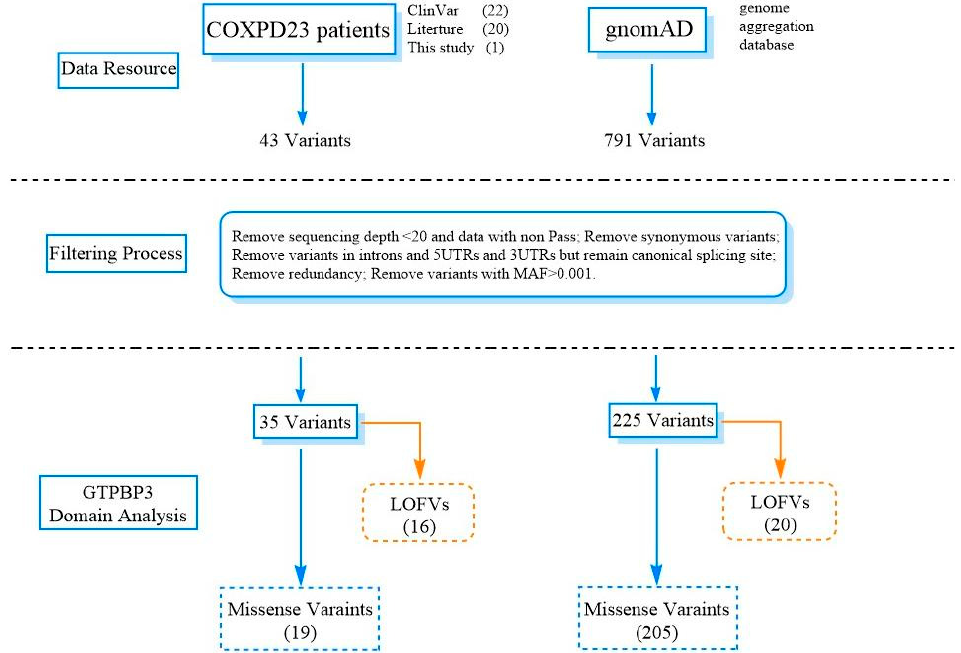
Figure 6. Workflow of the analysis of GTPBP3 variants. Comprehensive list comprising 791 variants from gnomAD and 43 pathogenic variants from ClinVar and clinical cases in the literature. Finally, it includes 225 rare variants from gnomAD and 35 pathogenic variants from clinical cases. LOFVs, loss of function variants, include nonsense variants, frameshift deletion/insertion, and splicing variants. Missense variants included missense variants and non-frameshift deletion/insertion with unknown significance.